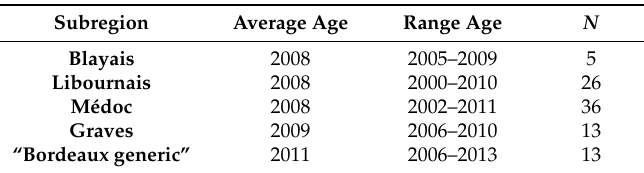
Table 4. Bordeaux wines by